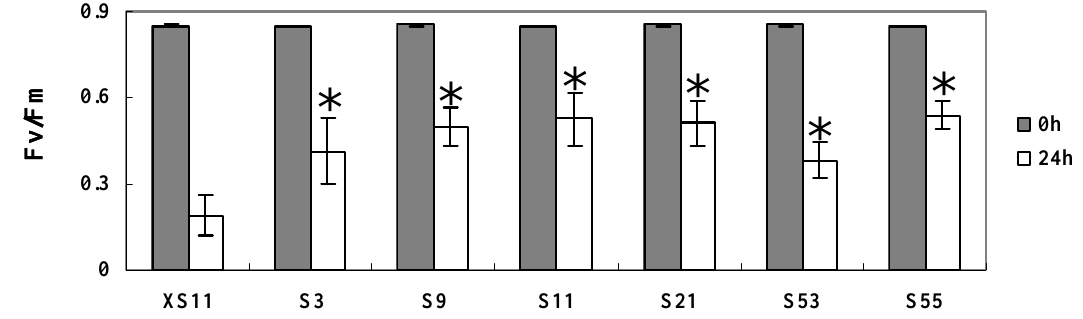
Figure 5. The effect of paraquat treatment on transgenic